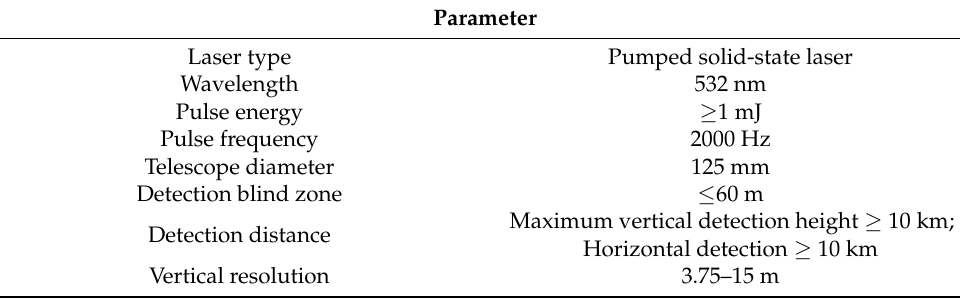
Table 1. Related parameters of the Ray-GB particle